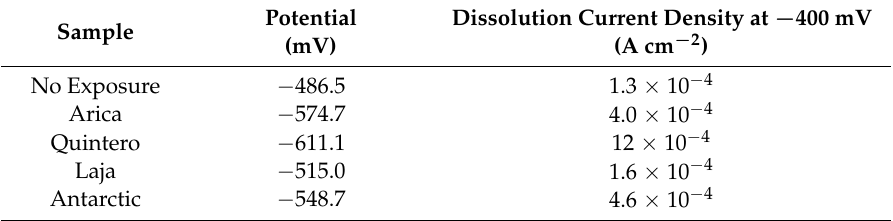
Table 4. Electrochemical parameters of the samples exposed for 36 months at different stations, obtained from the anodic polarization